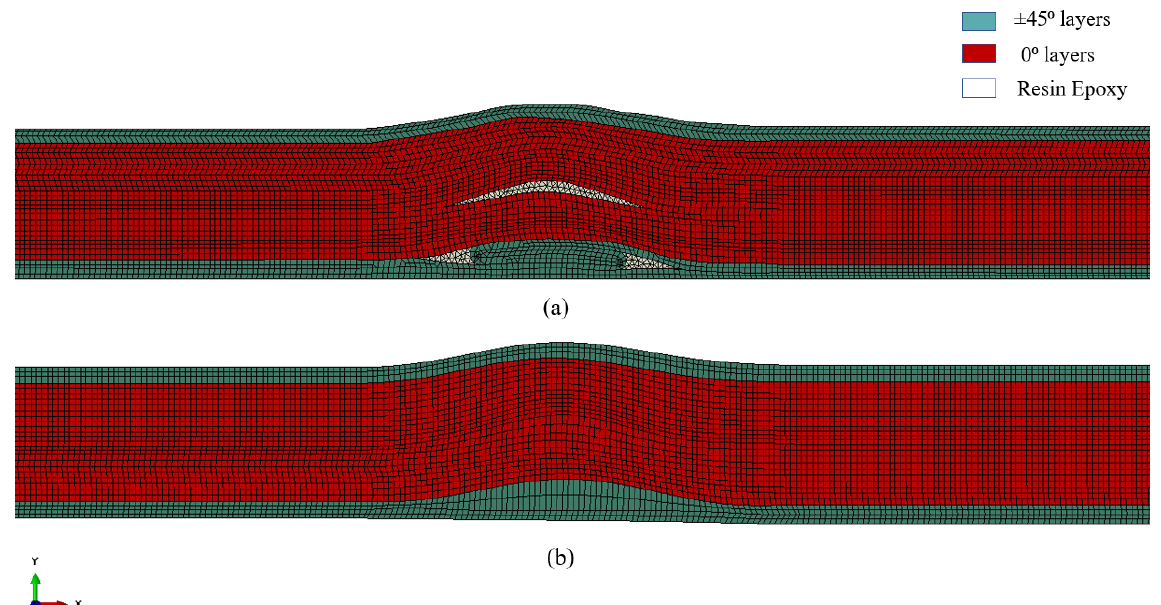
Figure 6. Comparison of mesh discretization with the geometric details of the wrinkle type 1 for the models: (a) HFM presents the geomet- rical complexities of a fold wrinkle and resin pocket (b) SM presents a simplified geometrical configuration.